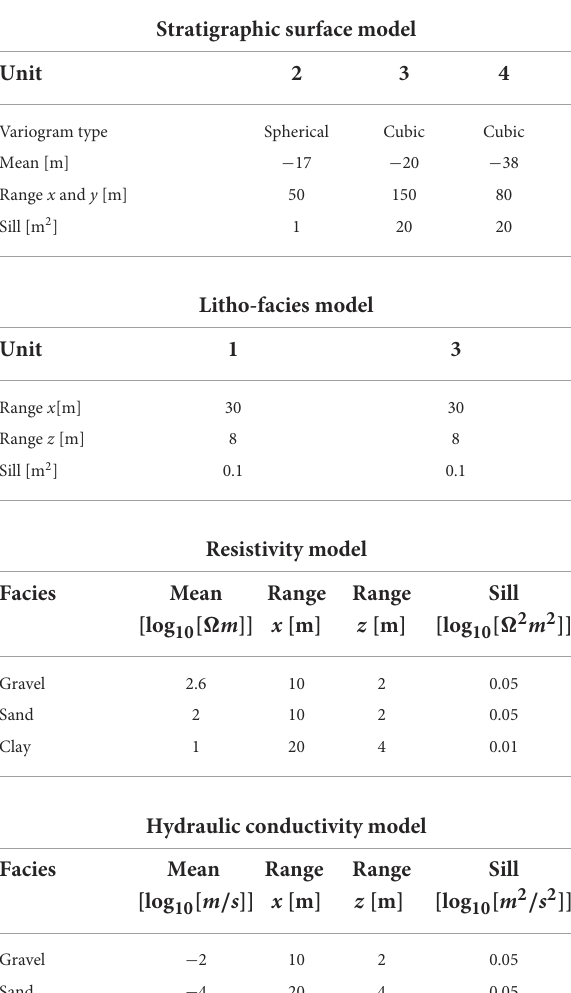
TABLE 1 Geostatistical parameters used by ArchPy to generate the geological